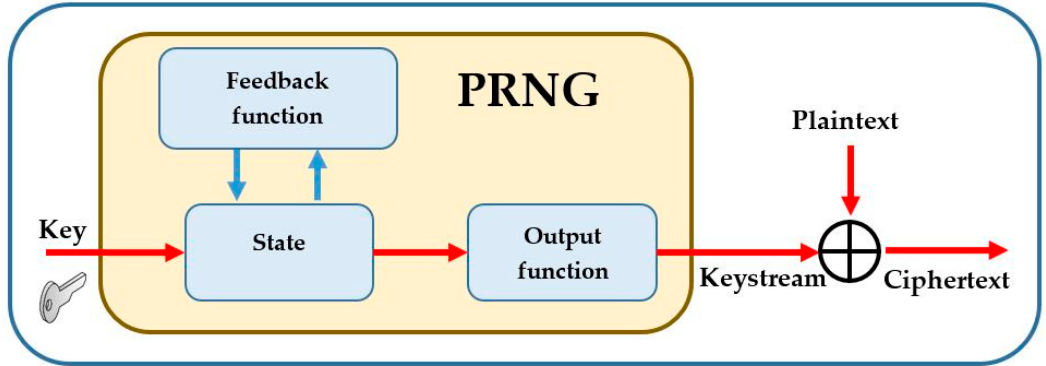
Figure 1. Generic scheme of a stream cipher composed by a PRNG (Pseudo-Random Number Generator) and an XOR gate. An internal state is constantly getting updated using a feedback function. This way, each value of the internal state is obtained as a function of the previous value and key. The final keystream is obtained from the internal states using an output function. Finally, the ciphertext is generated by XORing the plaintext with the keystream.